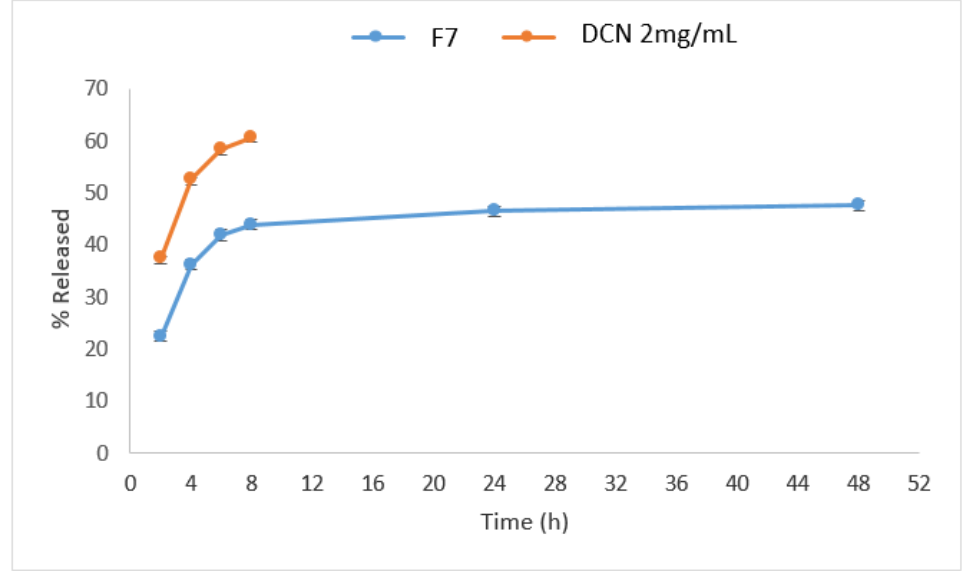
Figure 2. Release profile of DCN from the optimized hyaluosomes (F7) and DCN aqueous dispersion (2mg/mL).